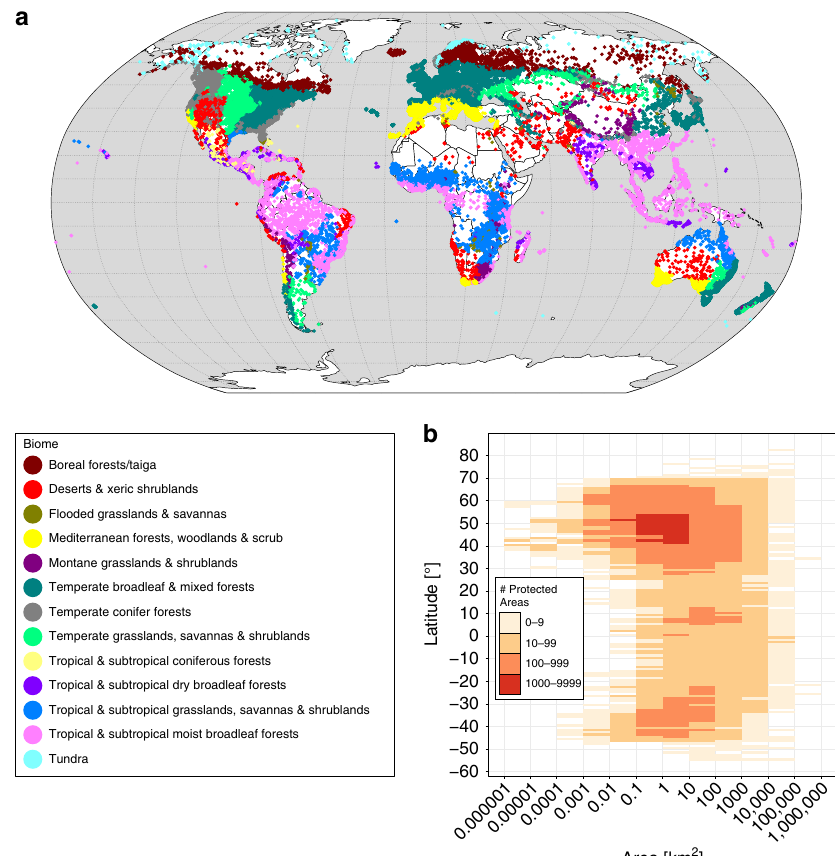
Fig. 1 Terrestrial protected areas of the Earth ’ s biomes. a The climate change analyses involve 137,432 terrestrial PAs that cover 20,658,583km², which is about 14% of the global land area (including Antarctica) and 99.9% of the global PA area. The colored dots represent the centroids of these PAs. The color indicates the biome of the PA. The map was created using open-source software R 52 . b The majority of PAs are located between 40° and 50° north. Their area ranges between 0.1 and 10